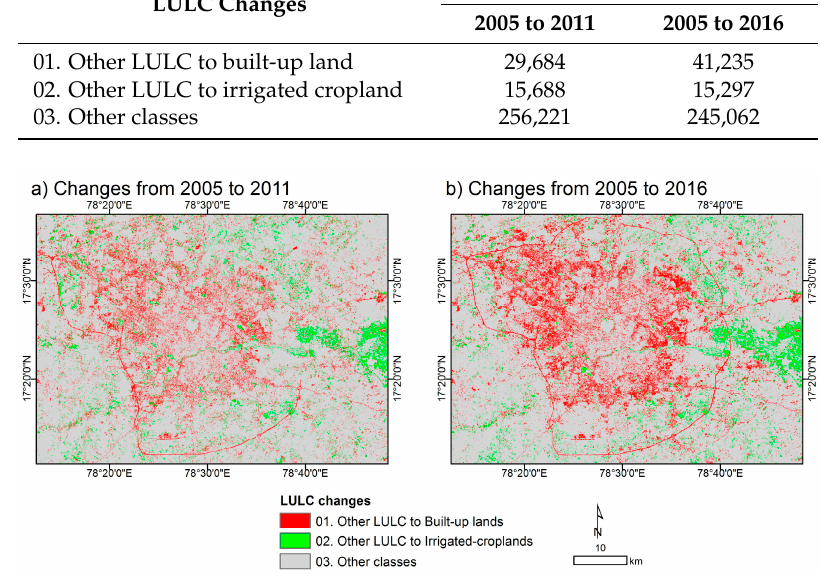
Figure 6. Land-use/land-cover (LULC) changes between 2005 and 2011 and between 2005 and 2016, based on Landsat-8, IRS-P6, and MODIS time series data.